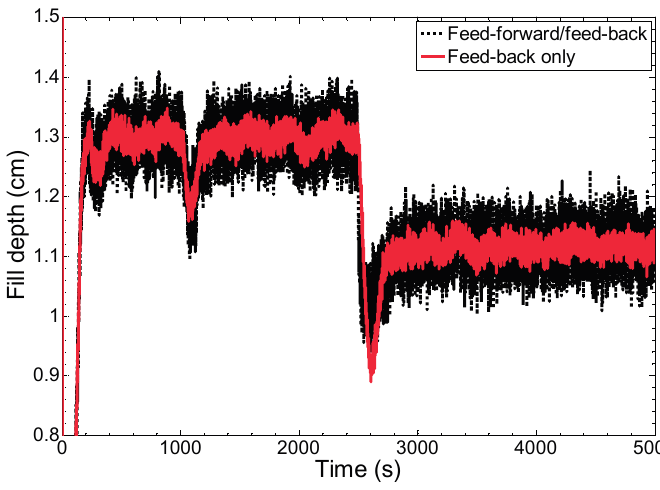
Figure 9. Comparison of actuators obtained from combined feed-forward/feed-back control strategy with feed-back only control strategy for main compression force